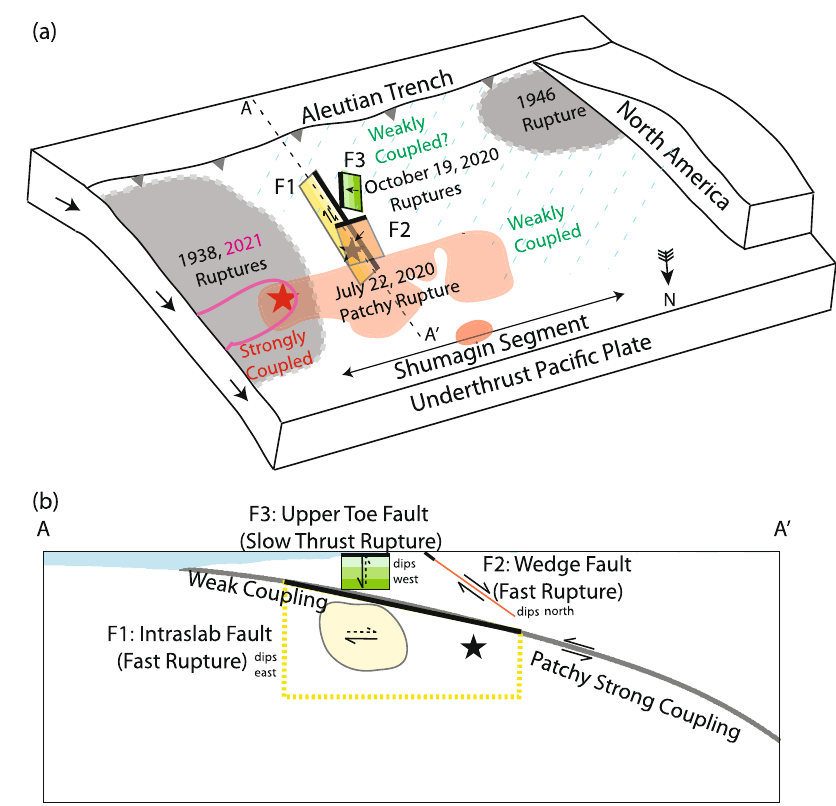
Fig. 10 | Model summary. a Schematic map and ( b ) vertical cross-section of the Shumagin Segment region indicating geometry of the preferred model with three faults that ruptured in the 19 October 2020 M W 7.6 event (black star indicates the hypocenter): F1 has fast strike-slip rupture within the underthrust Paci fi c plate (yellow zone); F2 has fast oblique-normal faulting rupture in the overthrusting NorthAmericaplate(orangezone);F3hasslowthrustfaultingruptureonafaultin